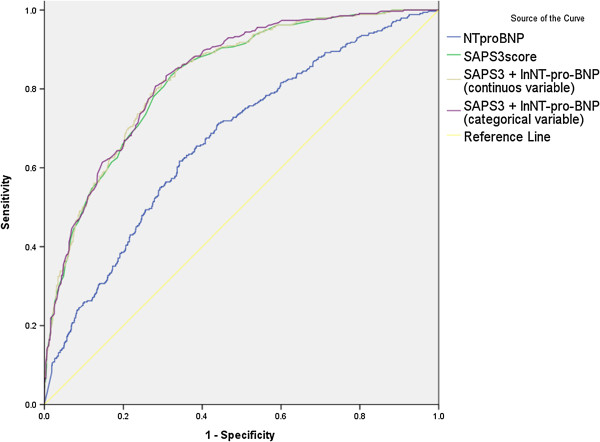
Receiver operating characteristic (ROC) curve analysis for hospital mortality. The area under the ROC curve was 0.67 for the NT-pro-BNP level and 0.83 for the SAPS 3 score. Combine of NT-pro-BNP level and SAPS 3 score resulted in little additional power.